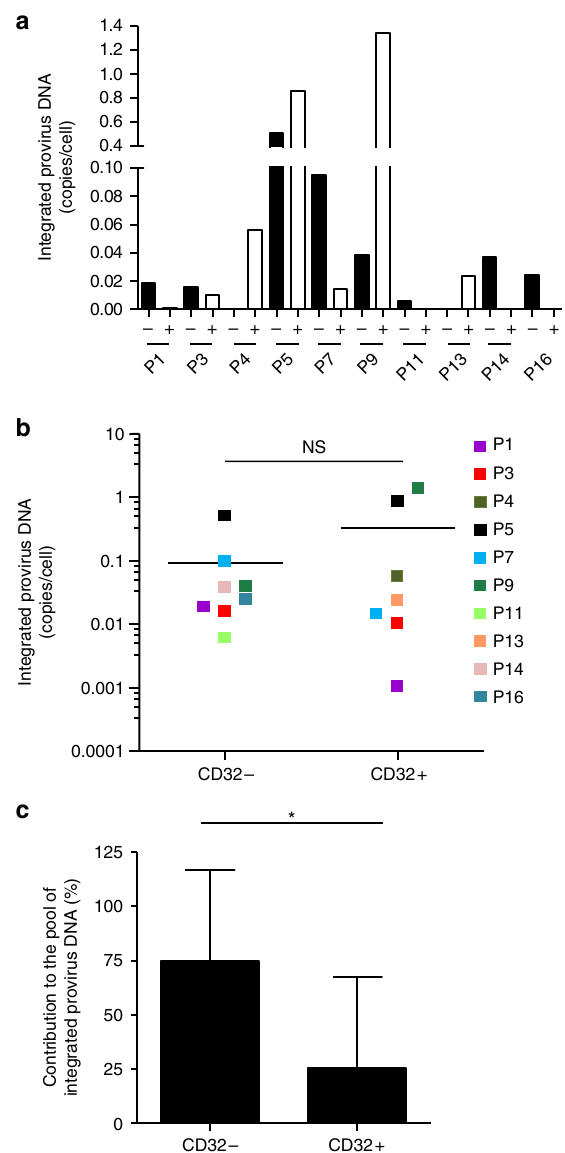
Fig. 5 Contribution of HIV-1 proviral DNA in the CD32 + /CD4 + T cells from HIV-1 individuals. a Quanti fi cation of HIV-1 integrated provirus HIV-1 DNA copies per cell in CD32 − (black bars) and CD32 + (white bars) CD4 T cells from 10 ART-treated individuals. b Individual HIV-1 integrated provirus DNA copies per cell in CD32 − and CD32 + CD4 T cells. The mean values are presented as horizontal lines. Each color represents values from the same HIV + individual. NS not signi fi cant ( p = 0.3). c Relative contribution of HIV-1 integrated provirus DNA in the CD32 − and CD32 + CD4 T cell compartments from 10 ART-treated individuals. The mean values are presented as the percentage relative to the total number of integrated provirus DNA copies. Student ’ s t -test, * p < 0.05 Con fi rmation of these fi ndings could also rede fi ne the concept of resting immune cells, not just for HIV.